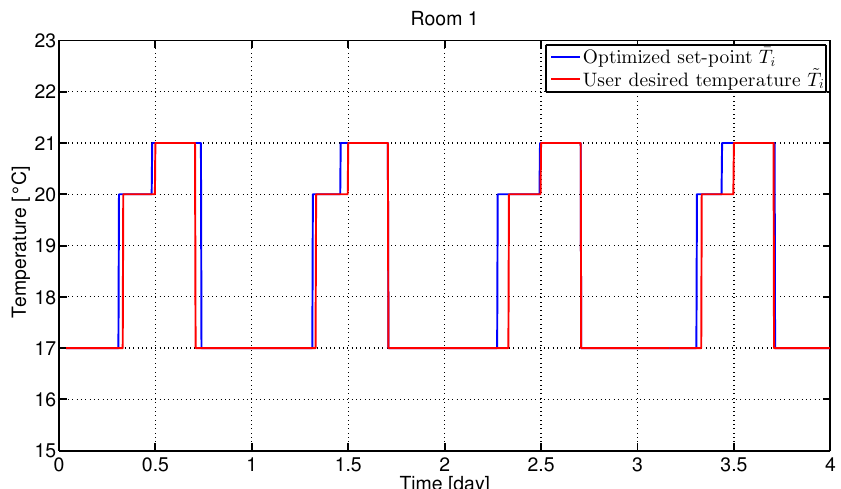
Figure 4. Four days simulation, from 15 November to 18 November, and optimal set-point signal planning, in case the optimized set point can change as a step signal. Red line: user defined set-point signal. Blue line: optimal set-point signal obtained by the genetic algorithm.